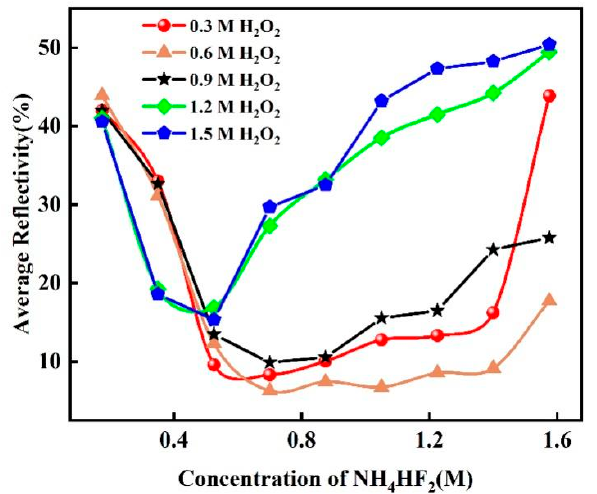
Figure 3. Dependence of samples surfaces average reflectivity on the concentration of H 2 O 2 and NH 4 HF 2 in mixed solution with 94 mM AgNO 3 and 9 × 10 –7 M PVP. All experiments were performed at 65 °C for 20 min.